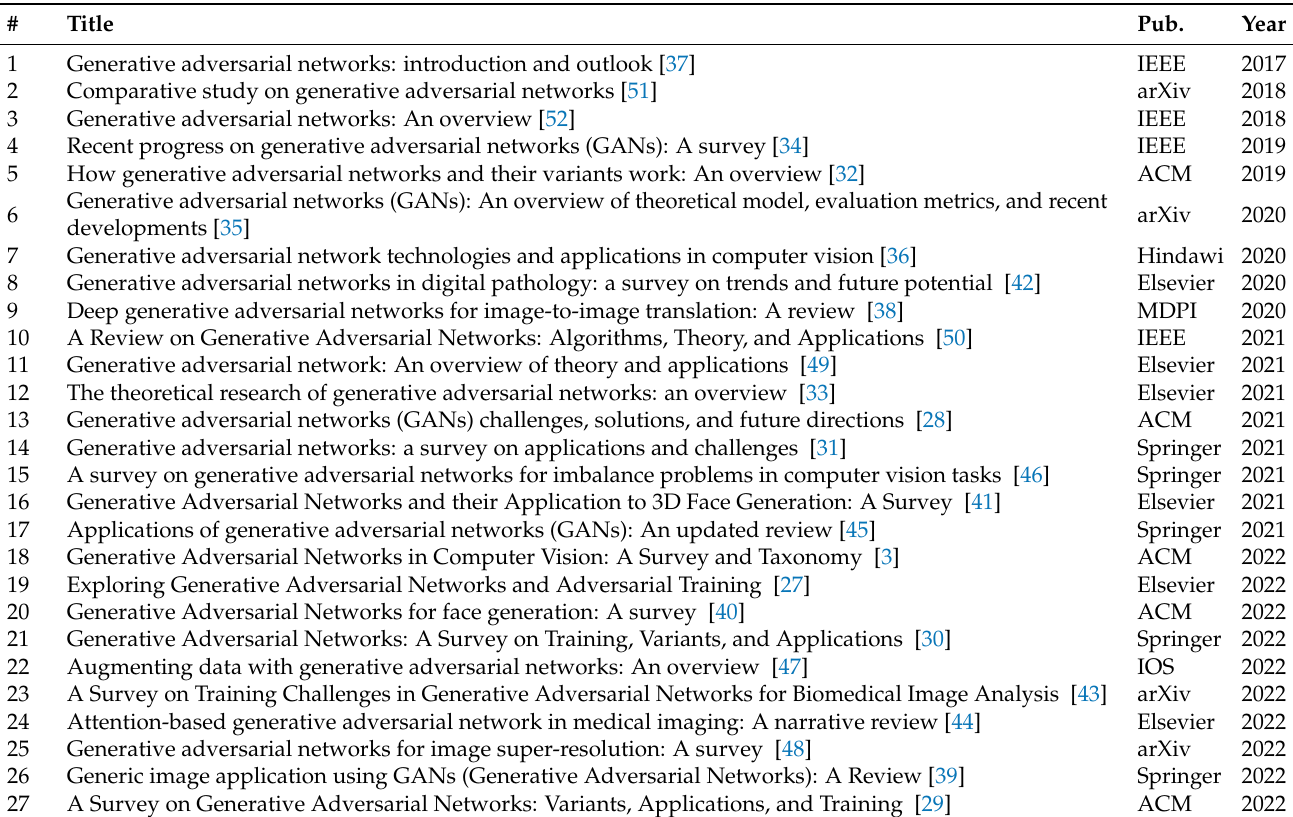
Table 2. Available survey articles about GAN that were published between 2017 and